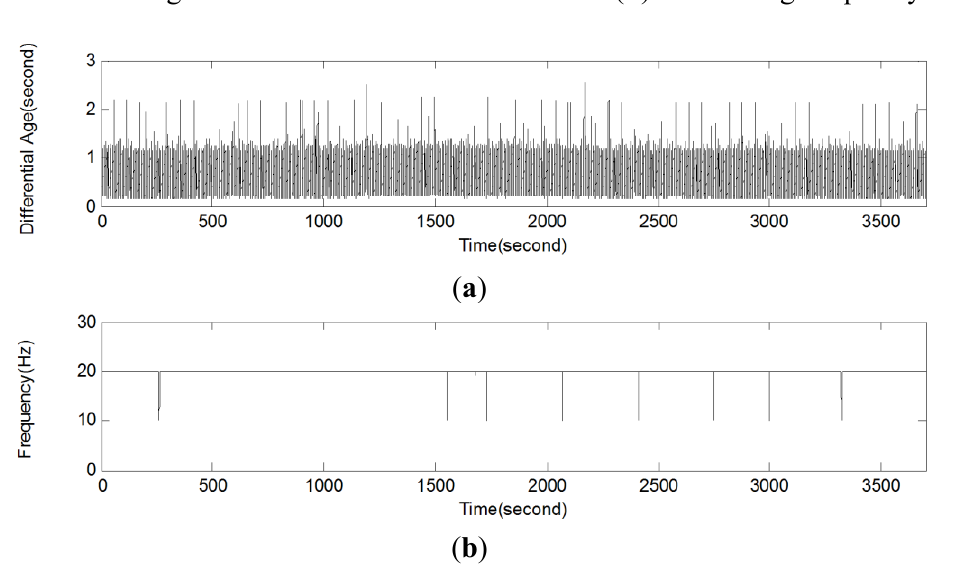
Figure 6. A Sample of test results (at Point 1) of performance evaluation. ( a ) Latency until the correction message transferred from the fixed station. ( b ) Positioning